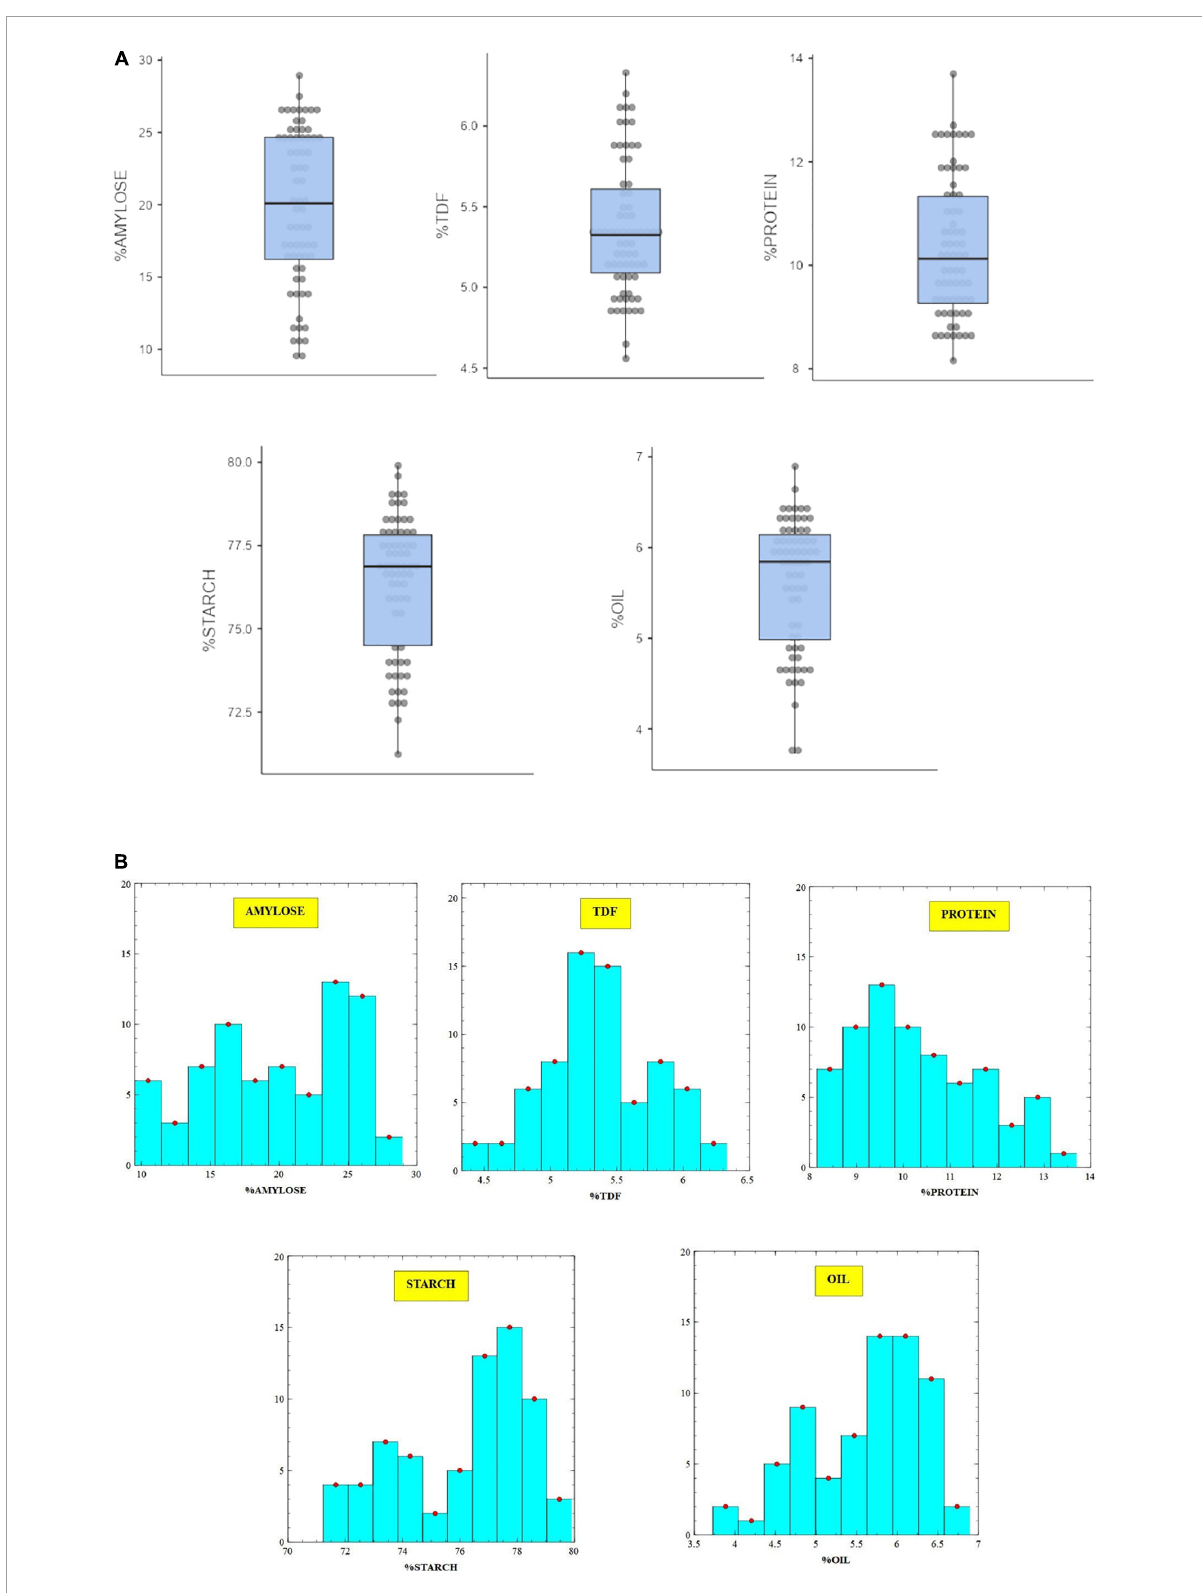
FIGURE1 (A, B) Variability of biochemical traits in brown rice germplasm through box and whisker plots and